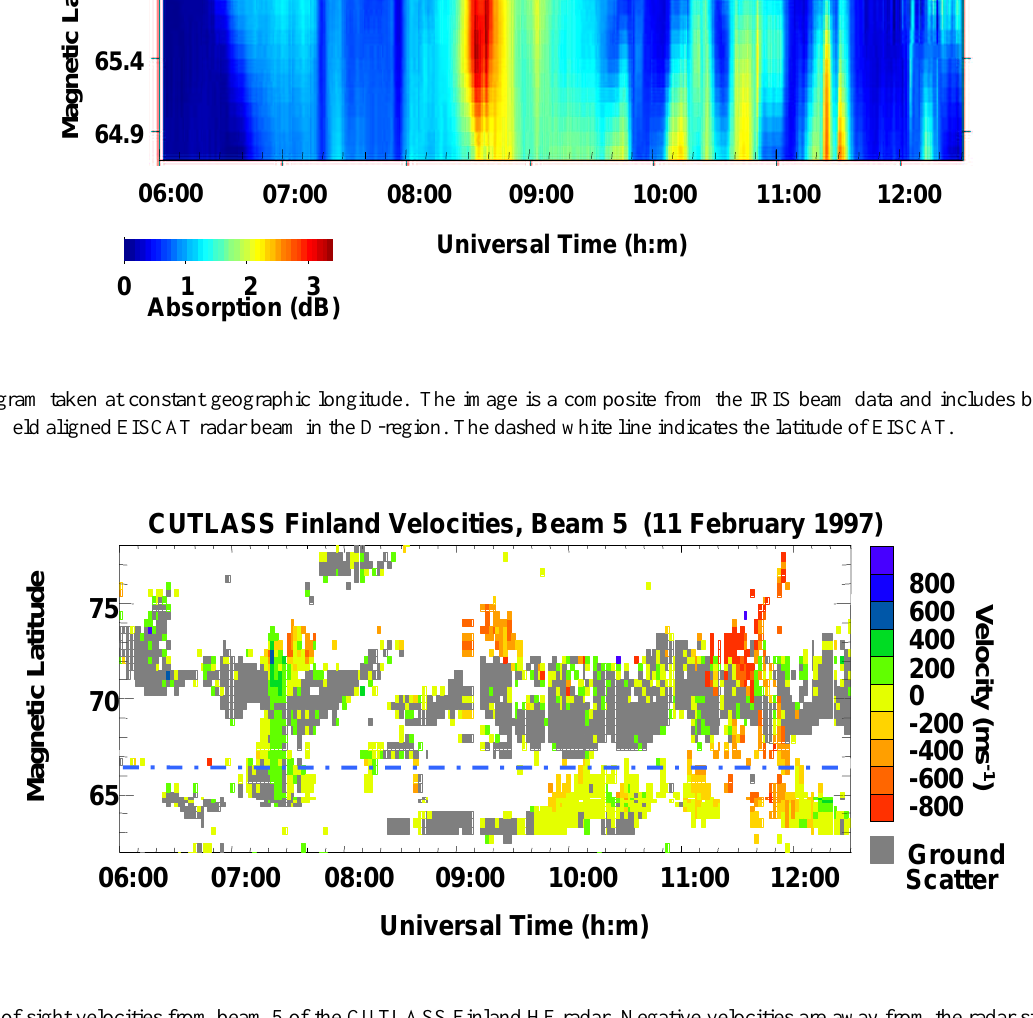
Fig. 7. Line of sight velocities from beam 5 of the CUTLASS Finland HF radar. Negative velocities are away from the radar site (approxi- mately poleward). The radar was operating under normal scanning mode for this period. The horizontal dashed line indicates the latitude of EISCAT. Data from the neighbouring CUTLASS beams show similar features but are not